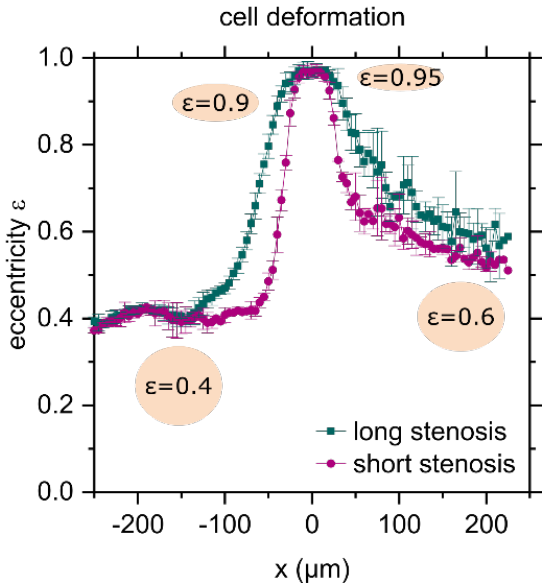
Figure 6. Cell deformation as a function of the x-position; the center of the stenosis is at x = 0. The shape of the cell is approximated by an ellipse. The eccentricity ε of an ellipse is the distance between the foci divided by the major axis length. The labelled ellipses illustrate the values. “Long” and “short” stenosis refers to stenoses with length e = 165 μm and e = 55 μm, respectively. The plotted eccentricity is the ratio of the distance between the foci of the ellipse and its major axis length. The value ranges between 0 and 1, where the degenerate cases are 0, a circle and 1, a line. Prior to passing the stenosis, the cells are already slightly elongated with ε = 0.4 . When passing the stenosis, the cell is deformed and lengthened, and the